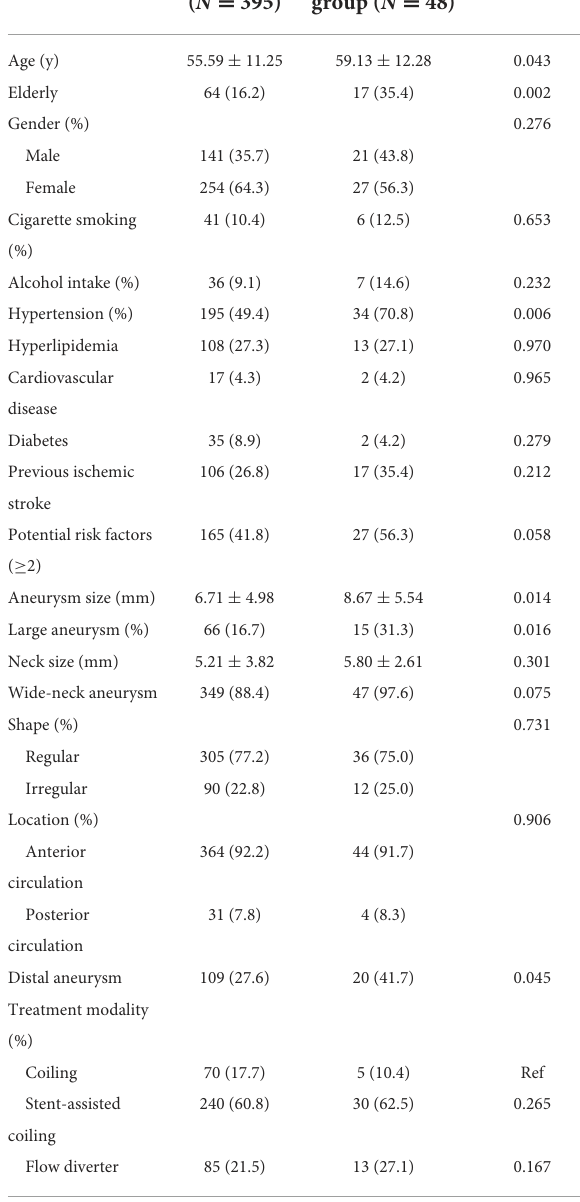
TABLE 1 Results from univariate logistic regression analysis for all variables. Characteristics Control